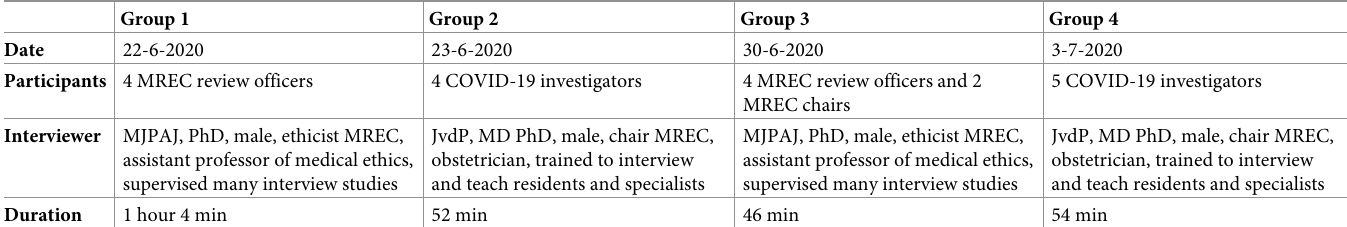
Table 1. Characteristics of group interviews.